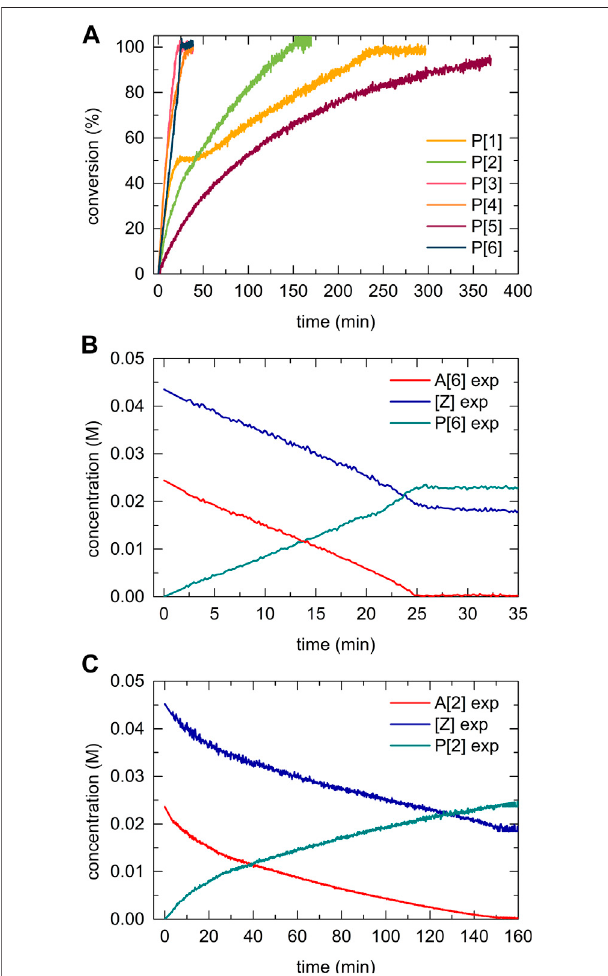
FIGURE 9 | Kinetic pro fi les of independent experiments of copper(I)- catalyzed cycloaddition reaction of bismuth(III) acetylides with an organic azide. Conditions: A [X] = 25mM; [Z] = 43 mM [cat] = 1.25 mM; 0.8 ml volume DMSO-d6; T = 59.5 ° C. (A) Standard reaction conversion vs. time (C) Concentration vs. time for tri fl uoromethyl functionalized substrate A [6], linear dependence reveals “ zero-order ” kinetics; (B) Concentration vs. time for tert - butyl functionalized substrate A [2], exponential dependence reveals positive value rate-order “ fi rst-order ” kinetics.